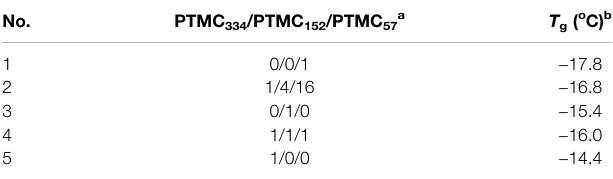
TABLE 2 | Preparation of PTMC fi lms and the ternary self-blending fi lms.